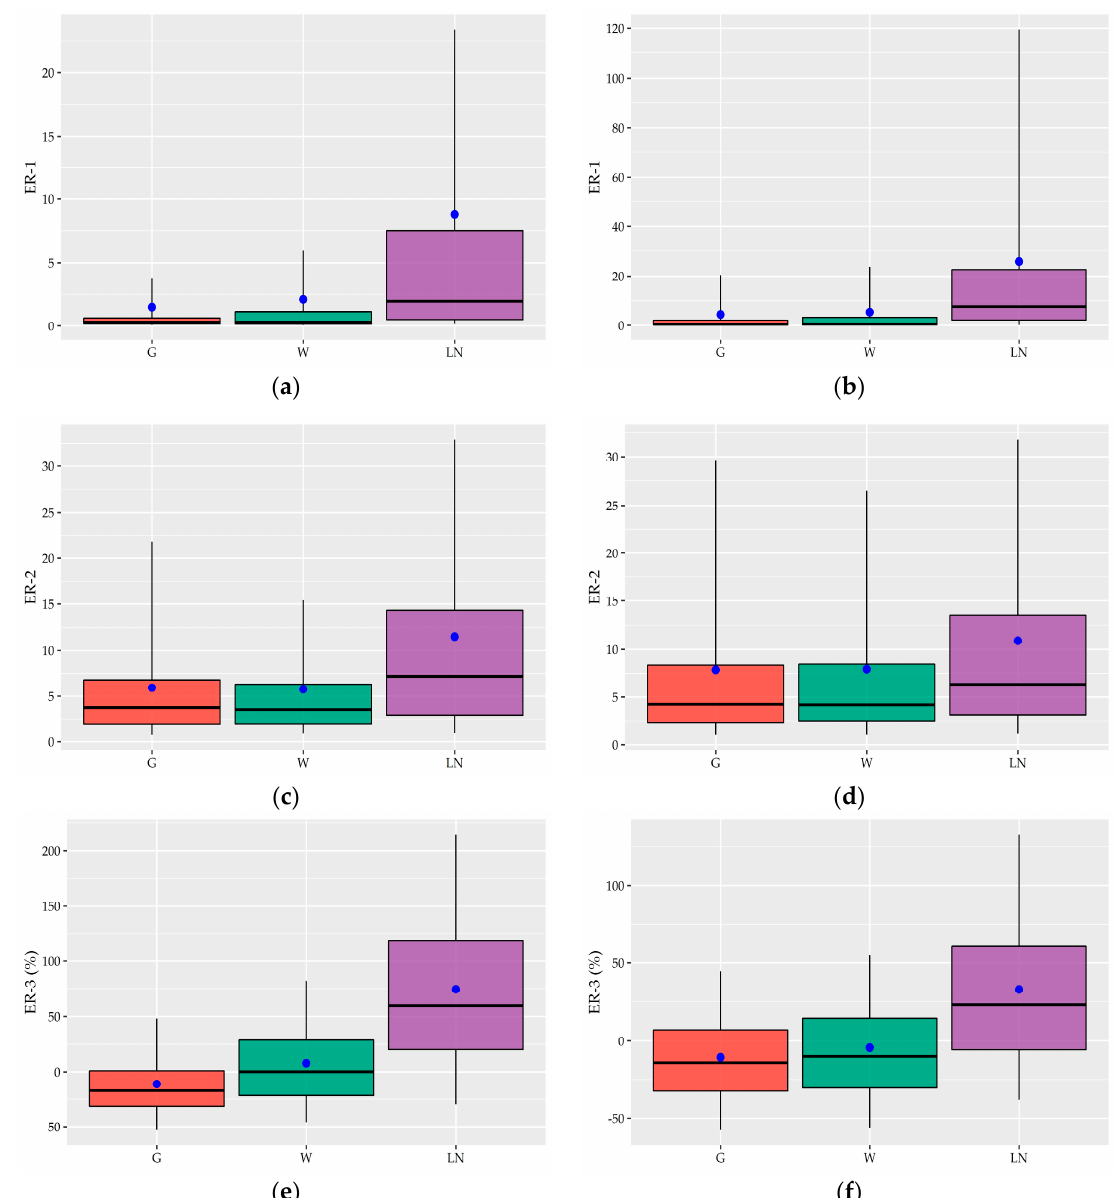
Figure 8. Box plots depicting the error measures that evaluate the fitting performance of the Gamma (G), Weibull (W), and Lognormal (LN) distribution to the nonzero 15-minute ( left column , a , c , e ) and hourly ( right column , b , d , f ) of 384 individual records. The blue points represent the mean value of the sample.